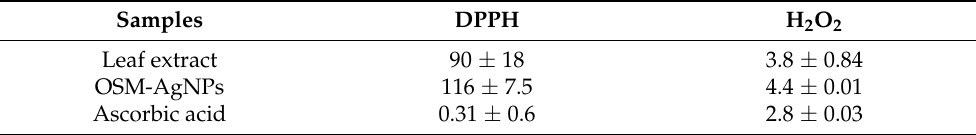
Table 2. Free radical-scavenging activities of leaf extract, OSM-AgNPs and ascorbic acid ( µ